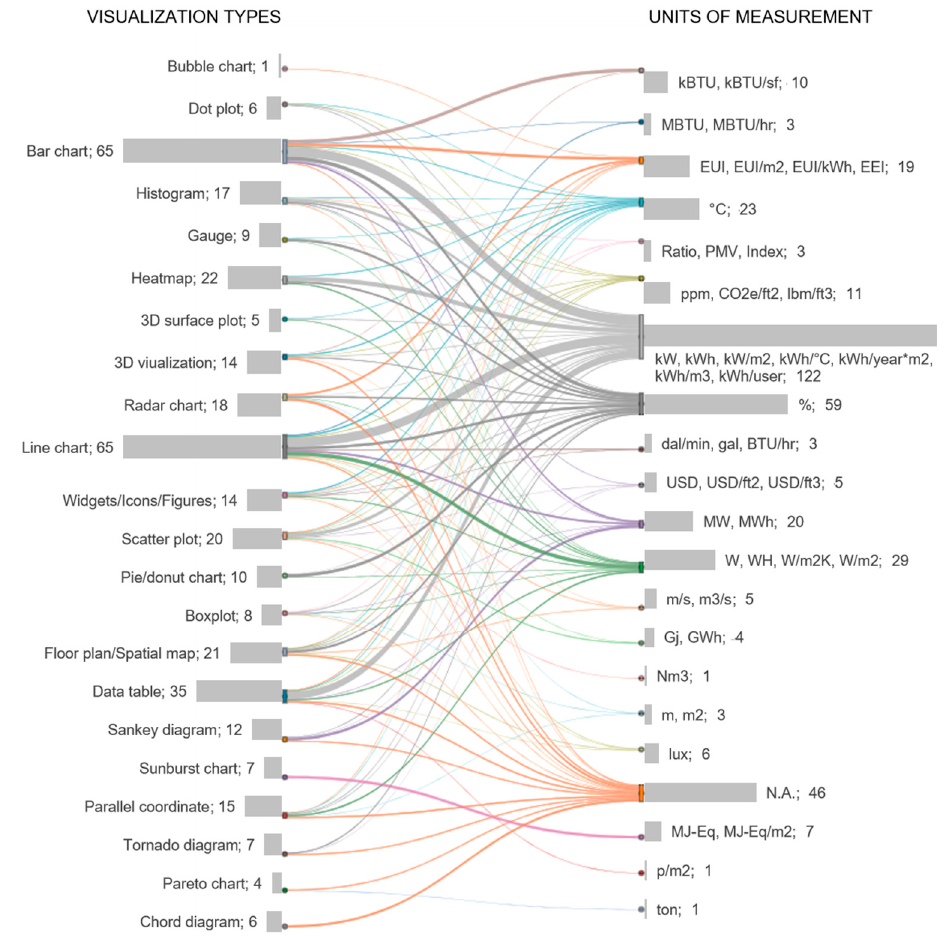
Figure 6. Relationships and trends between visualization types and their units of measurement. The values indicate the number of occurrences found.